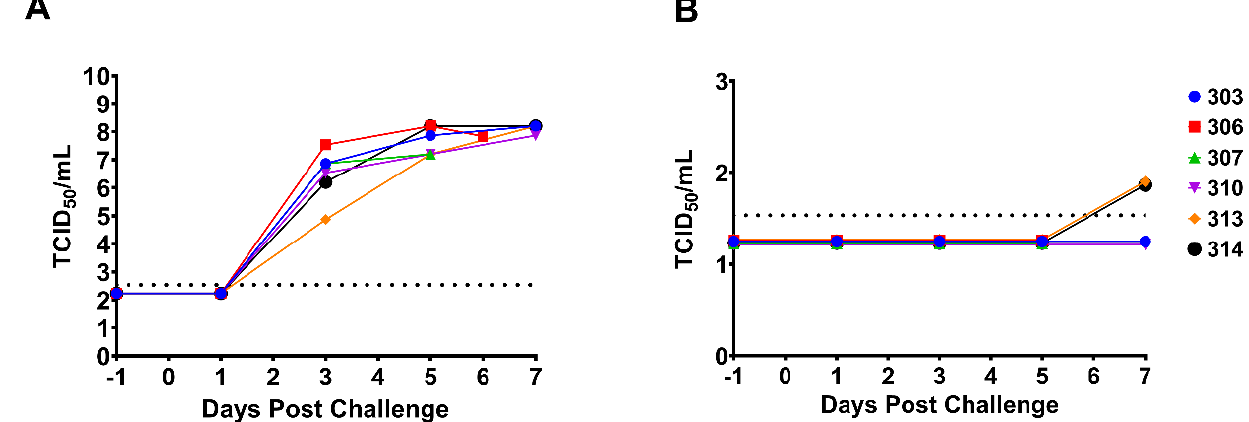
Figure 5. Viral titers in blood and OP swabs. ( A ) The log transformed viral titers (TCID 50 /mL) of ASFV-MNG19 in EDTA blood collected on − 1, 1, 3, 5, and 7 DPC. All samples were run in triplicate. The datapoints represent the calculated titers using the Spearman–Karber method. The dashed line represents the limit of detection for the assay. Datapoints for individual pigs are represented. The single data point at 6 DPC represents samples collected from pig #306 that was found dead. ( B ) The log transformed viral titers (TCID 50 /mL) of ASFV-MNG19 in OP swabs collected on − 1, 1, 3, 5, and 7 DPC. All samples were run in triplicate. The datapoints represent the calculated titers using the Spearman–Karber method. The dashed line represents the limit of detection for the assay. Datapoints for individual pigs are represented.